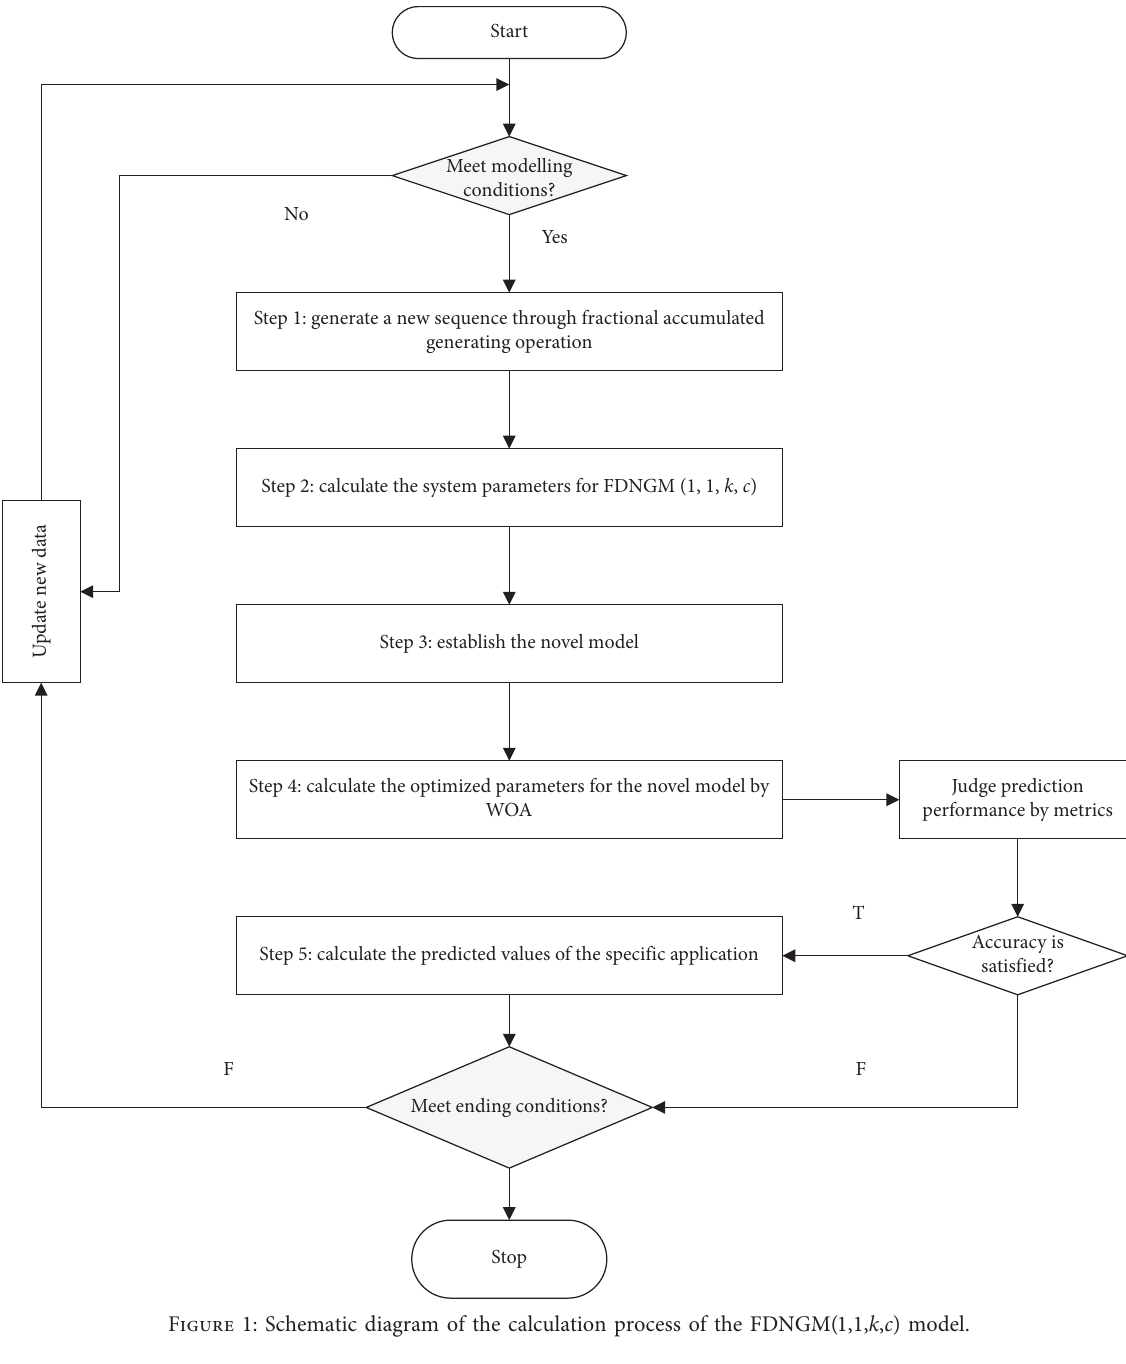
Figure 1: Schematic diagram of the calculation process of the FDNGM(1,1, k , c )